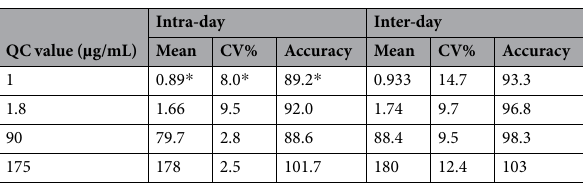
Table 3. Intra-day and inter-day precision (CV%) and accuracy of cetuximab quantification. Results from HT4 (A) and LT3 (B) peptides. * : Intra-day variability at LLOQ (1 µ g/mL) was evaluated simultaneously with matrix effects in six individual batches of human plasma.